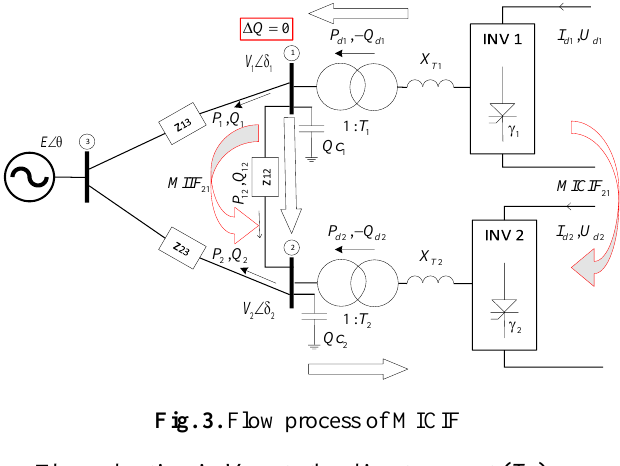
Fig. 3. Flow process of MICIF